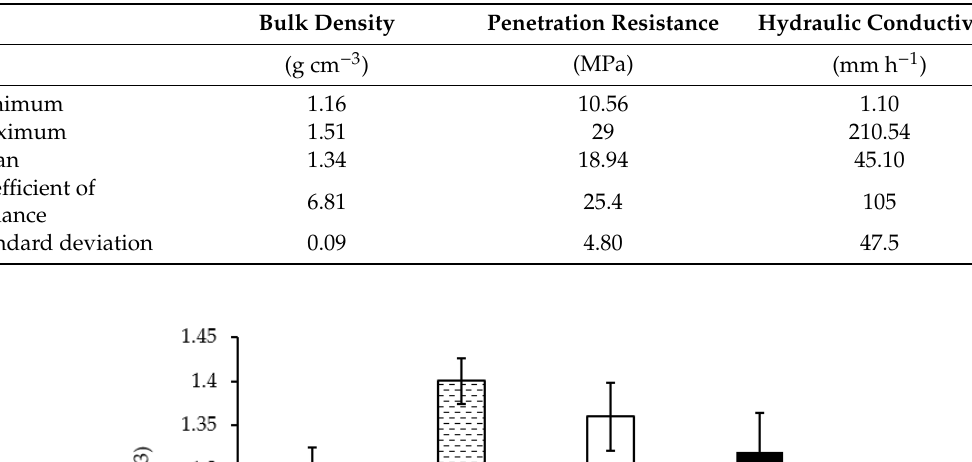
Table 4. Descriptive statistics of the parameters measured in the study.